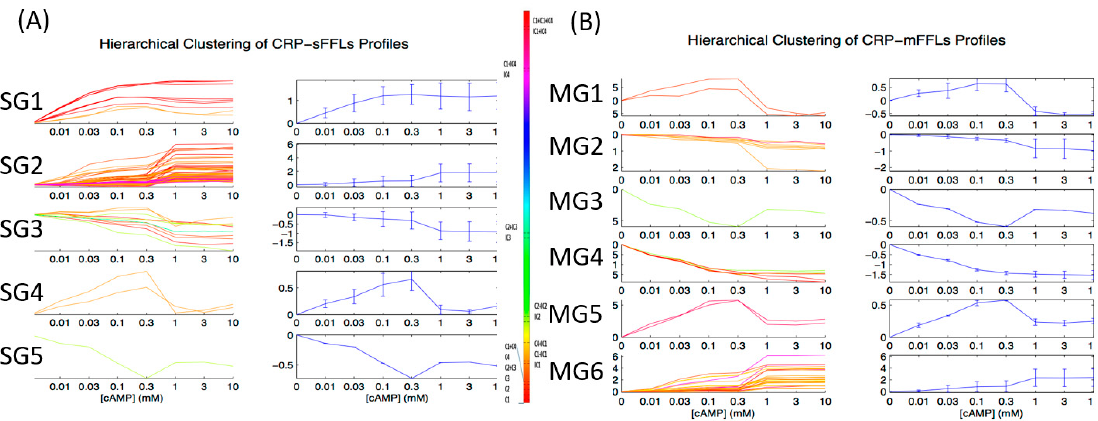
Figure 4. Expression profiles of CRP-sFFLs and CRP-mFFLs. Colored CRP-FFLs are used to distinguish between the various CRP-FFL types. The CRP-FFLs were divided into five groups (SG1 to SG5) in CRP-sFFLs and six groups (MG1 to MG6) in CRP-mFFLs according to distinct cAMP dose–response profiles. Hierarchical clustering results for ( A ) CRP-sFFLs and ( B ) CRP-mFFLs.